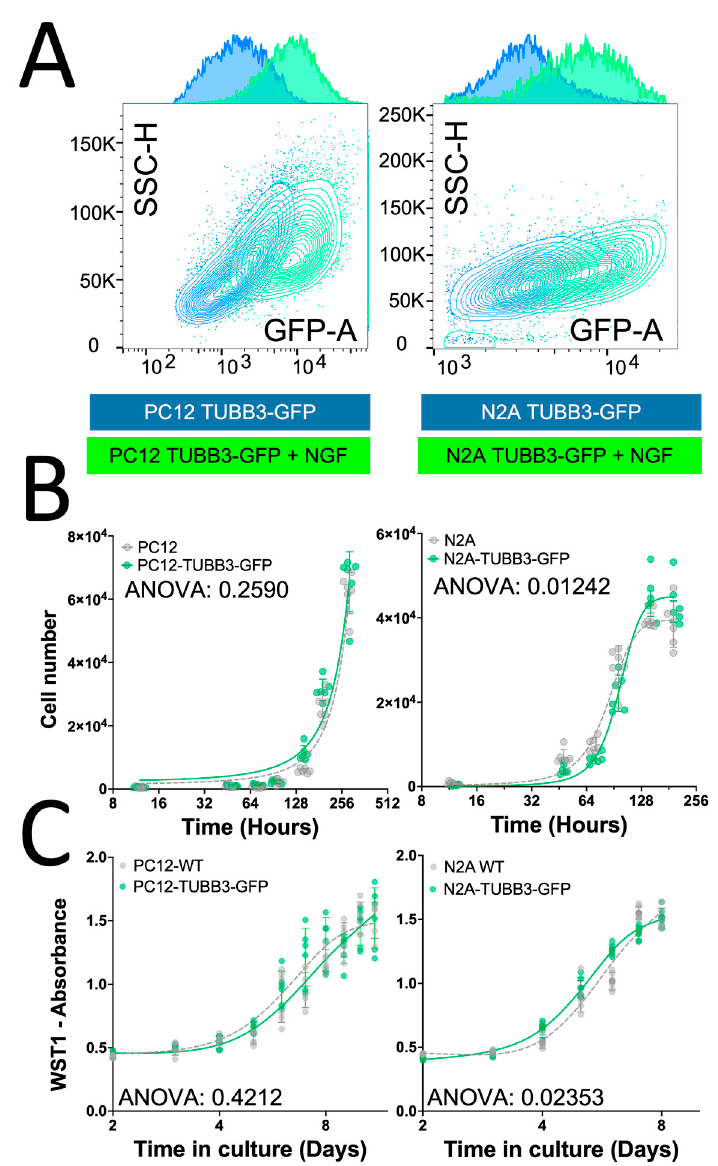
Figure 4. Endogenous tagging of TUBB3 does not compromise cell integrity. ( A ) Endogenous tag- ging of β 3-tubulin was performed in rat-derived PC12 ( left ) and mouse-derived Neuro2A ( right ) cell lines. Both cell lines showed a consistent increase in expression of β 3-tubulin-GFP after NGF stimulation (100 ng/mL) as analyzed by fl ow cytometry. ( B ) Endogenous labeling of β 3-tubulin